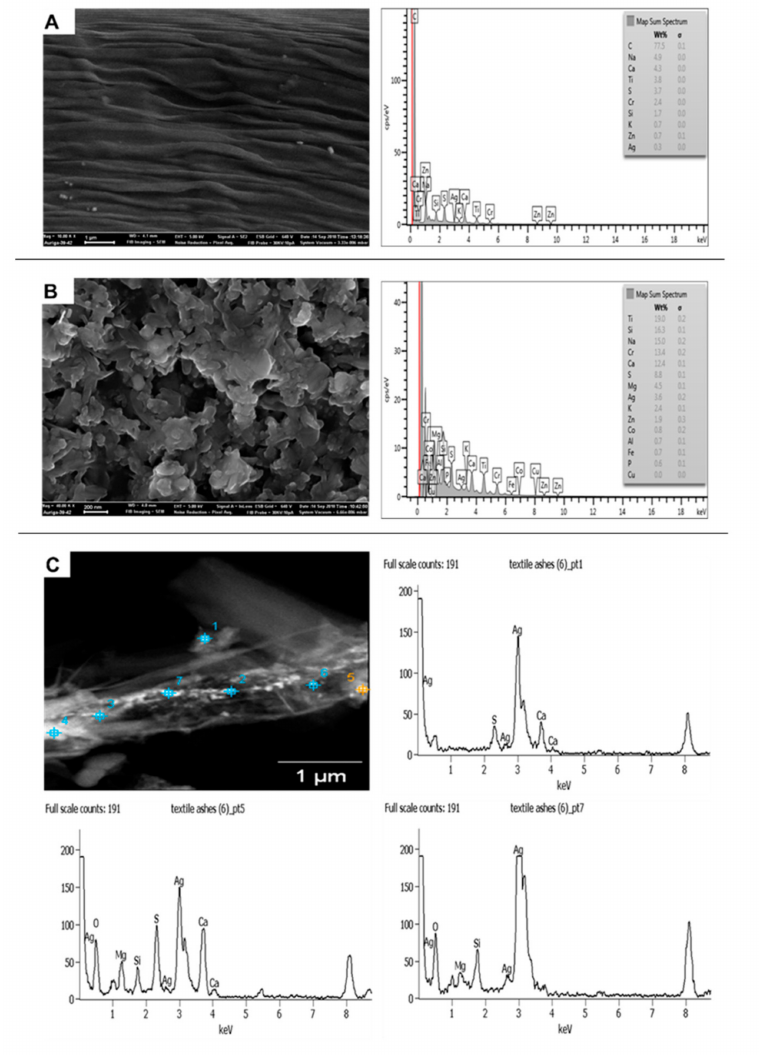
Figure 8. Scanning electron microscopy coupled to energy-dispersive X-ray (SEM-EDX) images of non-ashed ( A ) and ashed ( B ) SK1 and TEM-EDX of SK1 showing nAg in a straight line within the fibre ( C